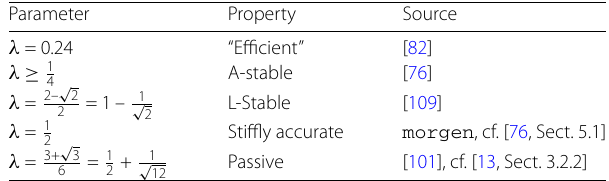
Table 3 Parameter choices for the implicit 2nd-order IMEX-RK component Parameter Property